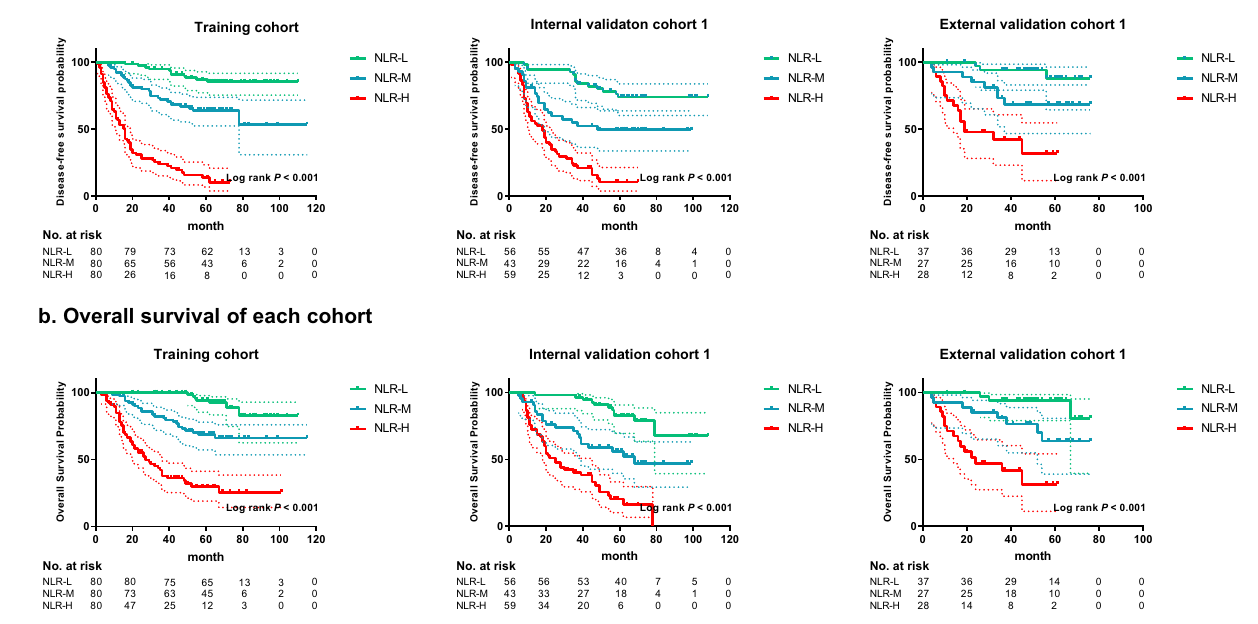
Fig. 2 | Kaplan – Meier analyses of disease-free survival (DFS) and overall survival (OS) according to different NLR statuses of the TIME in patients with gastric cancer. a Disease-free survival according to different NLR statuses of the TIME in the training cohort, internal validation cohort 1, and external validation cohort 1. b Overall survival according to different NLR statuses of the TIME in the